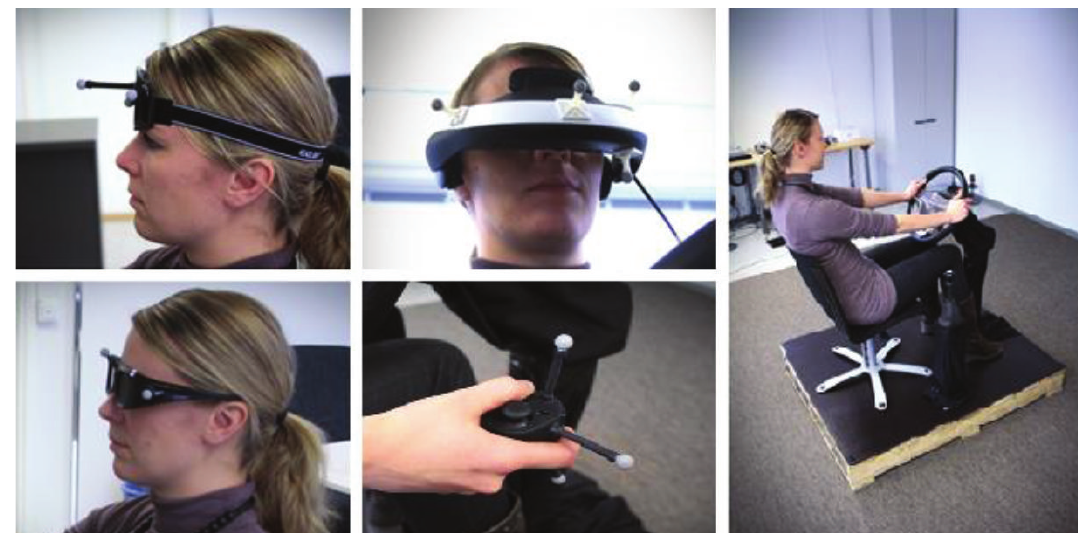
Figure 1: The devices used in the experiment: upper left: headband; lower left: 3D glasses; upper centre: head-mounted display (HMD); lower centre: the controller; right: car skeleton.